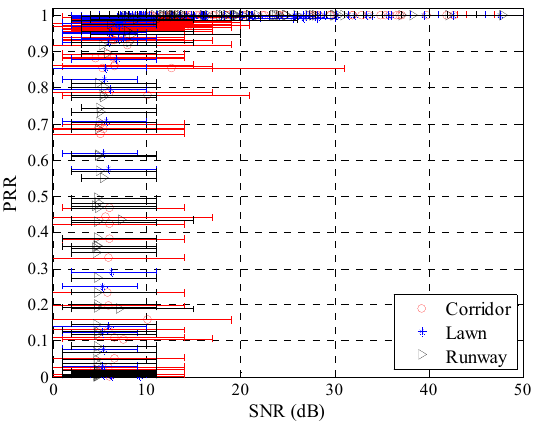
Figure 12. SNR vs. PRR in different environments.